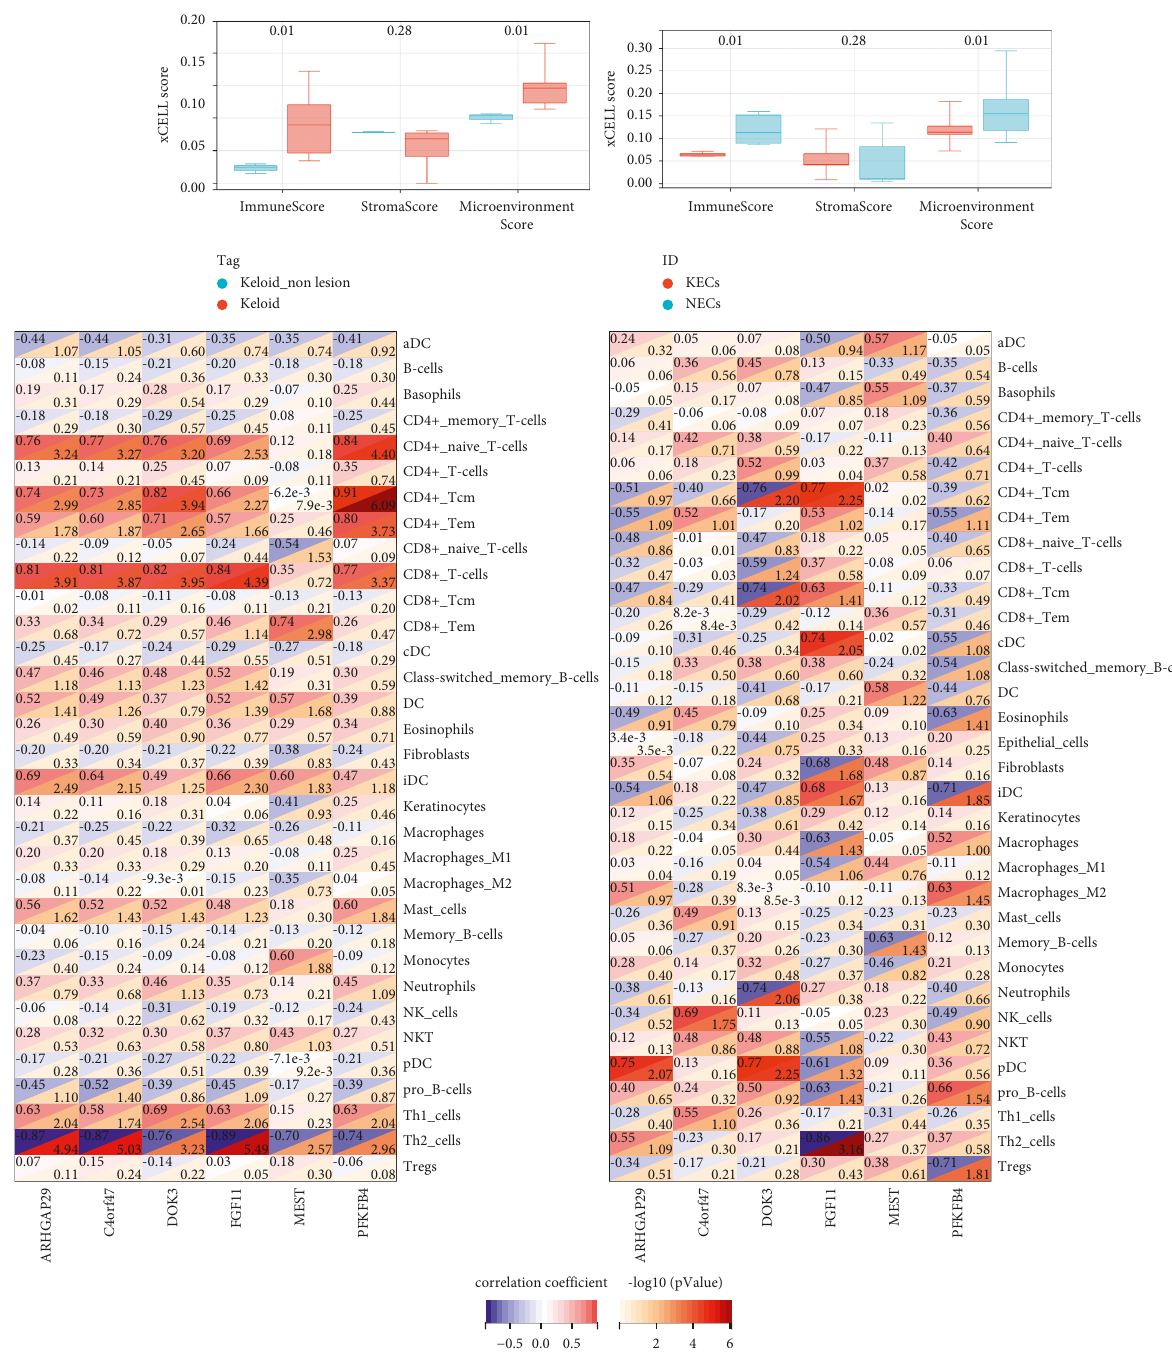
Figure 4: Comparison of immune infiltration scores in keloid and nonkeloid lesions contrary to normal scar and their correlations with individual infiltration scores of immune-related cells. verification of the immune infiltration differences and correlations between key genes and infiltration of immune-related cells in